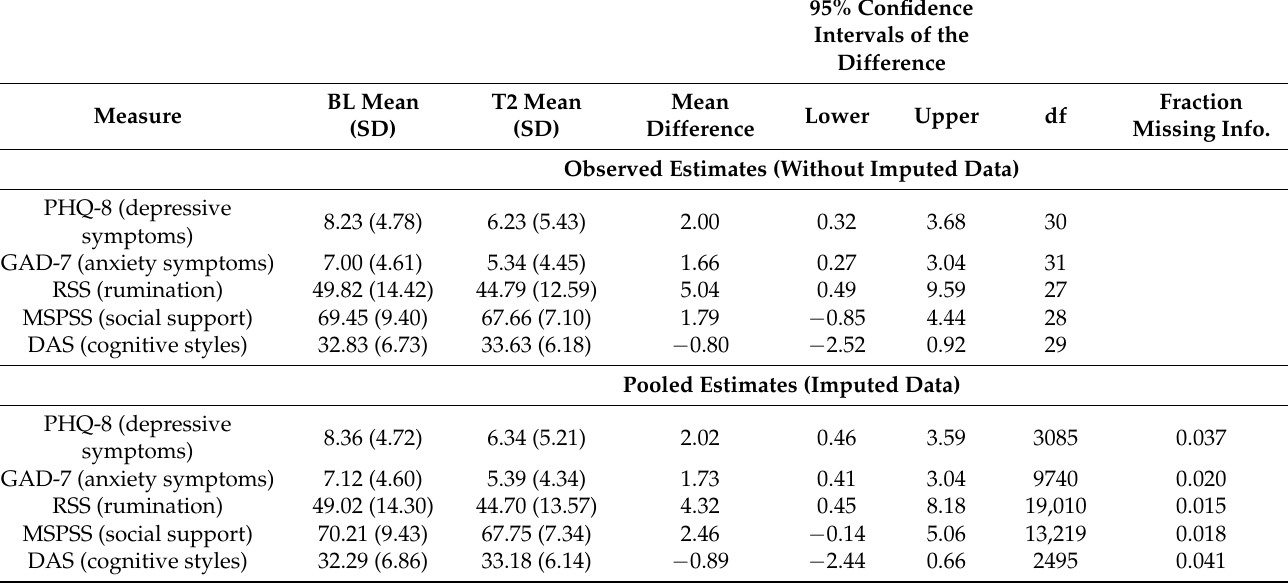
Table 3. Clinical measures at baseline and eight